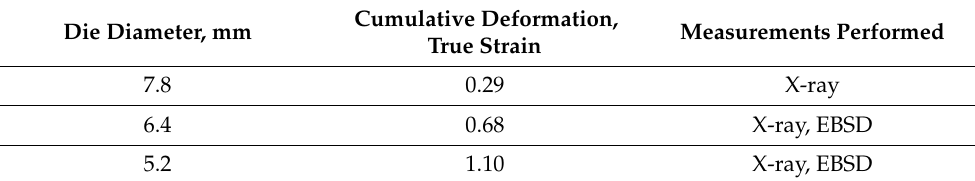
Table 1. Summary of die diameters used during drawing process together with cumulative deforma- tion applied at given processing step. Cumulative Deformation, Die Diameter, mm Measurements True Strain